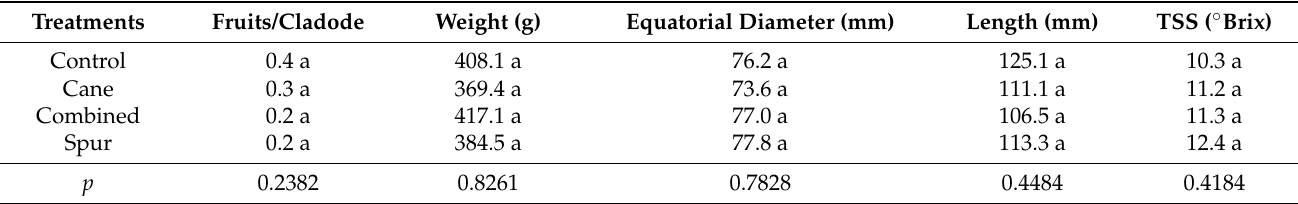
Table 4. Fruit production per cladode and fruit characteristics as an average in the second harvest in response to different pruning treatments.